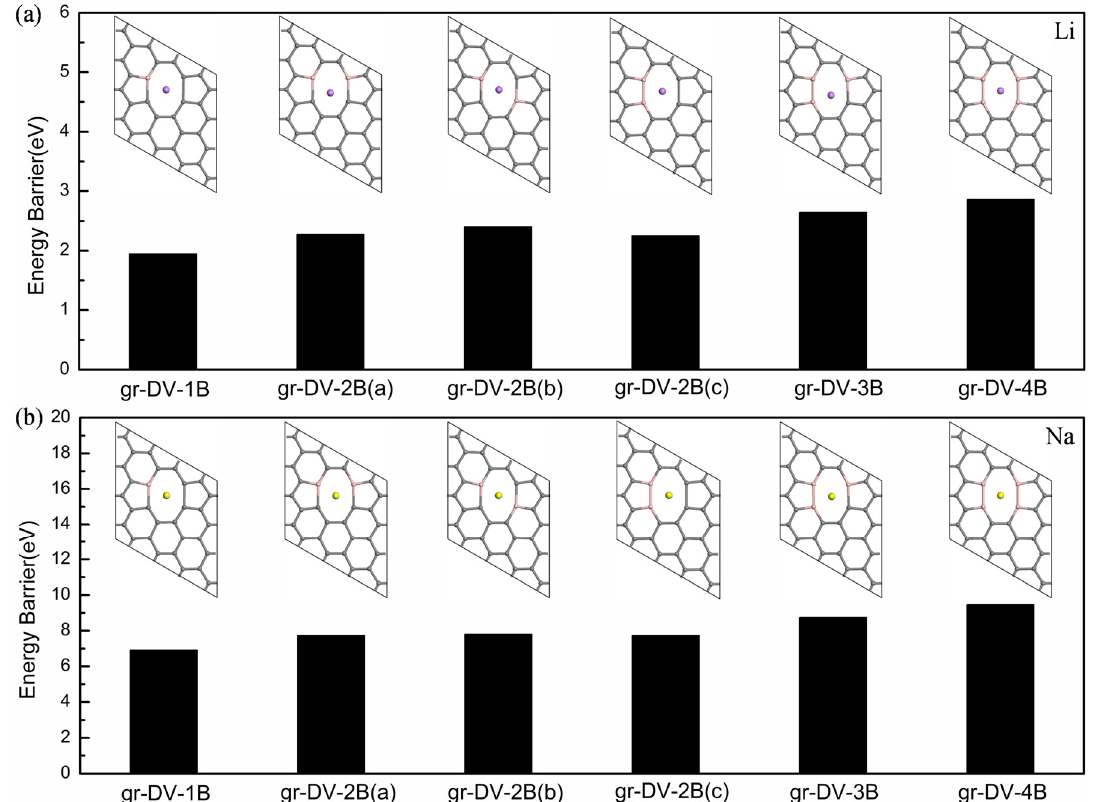
Figure 6. Relaxed structures and corresponding diffusion barriers for B-doped graphene with DV: ( a ) Li and ( b ) Na.